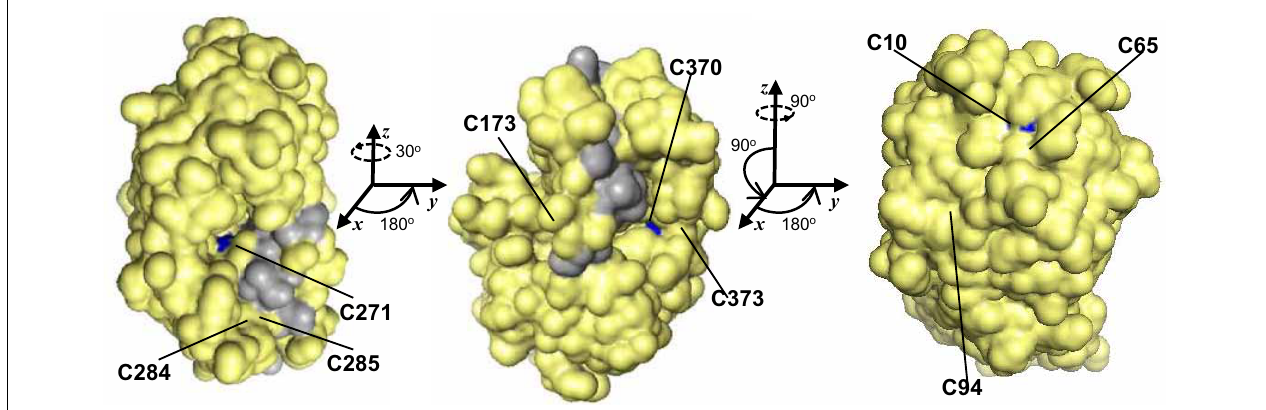
FIGURE 2 | Of nine positionally-conserved ex-zinc cysteines in GSNOR three are solvent-accessible. Three orientations (rotation angles indicated) of a monomer of the Arabidopsis GSNOR dimer are shown with solvent